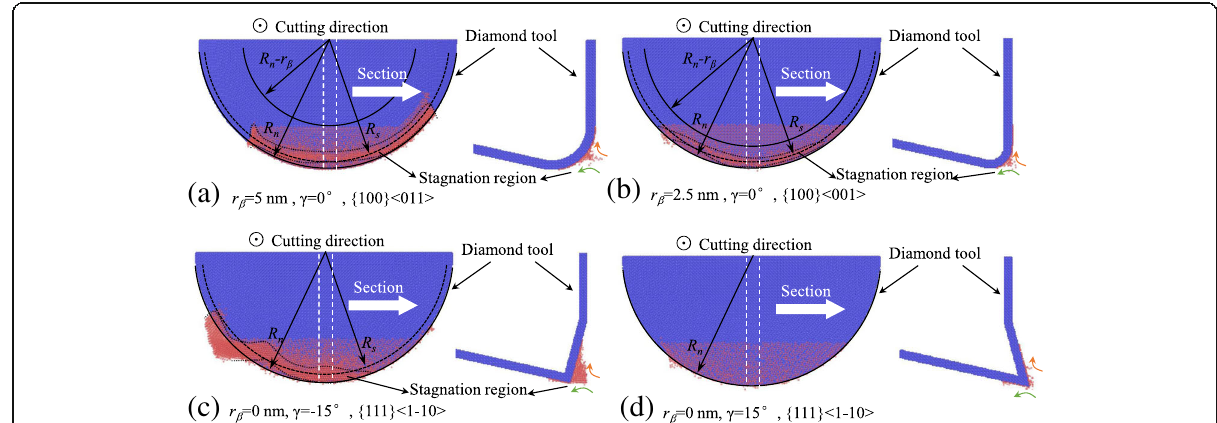
Fig. 3 Stagnation region on the cutting tool